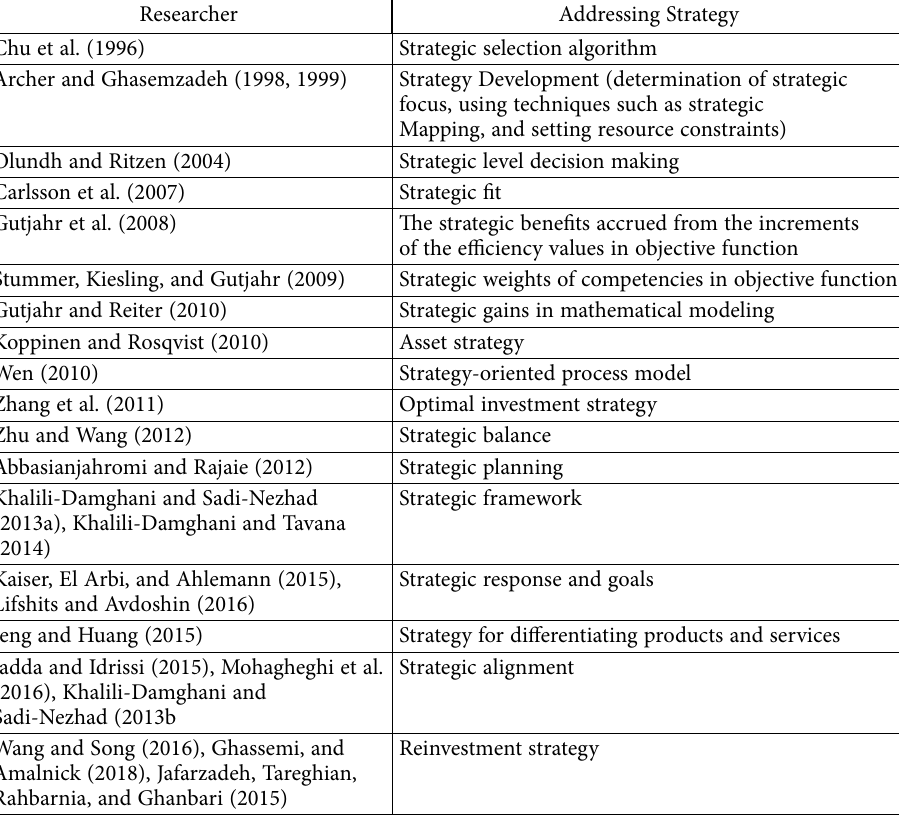
Table 4. Various forms of addressing strategy